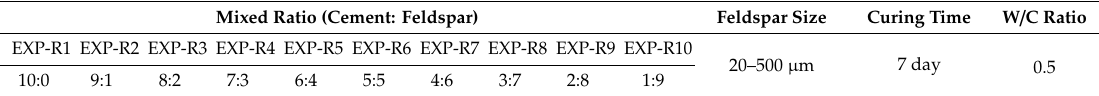
Table 2. Test conditions for reactivity of cement and feldspar.